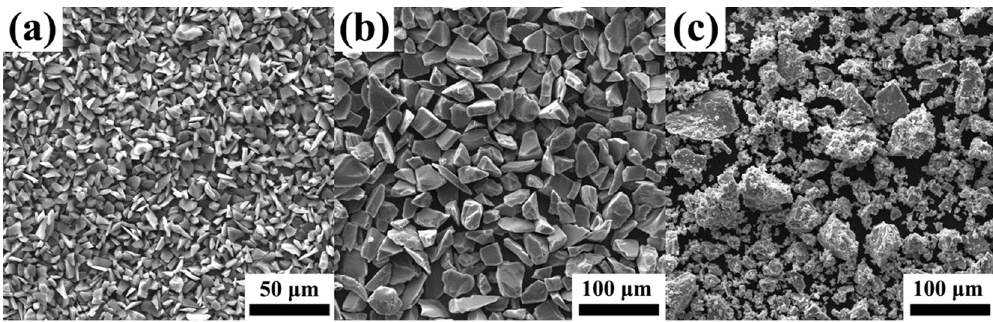
Figure 1. The morphologies of the reinforcements used here: ( a ) 7 μ m SiC particles; ( b ) 35 μ m SiC particles and ( c ) 35 μ m Ti metal particles.